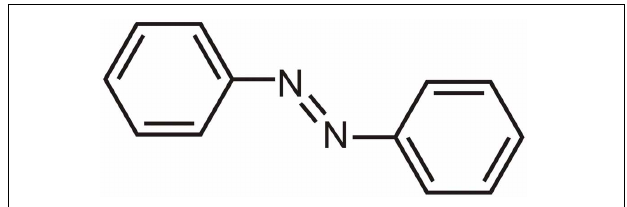
FIGURE 1 | Chemical structure of the trans isomer azobenzene